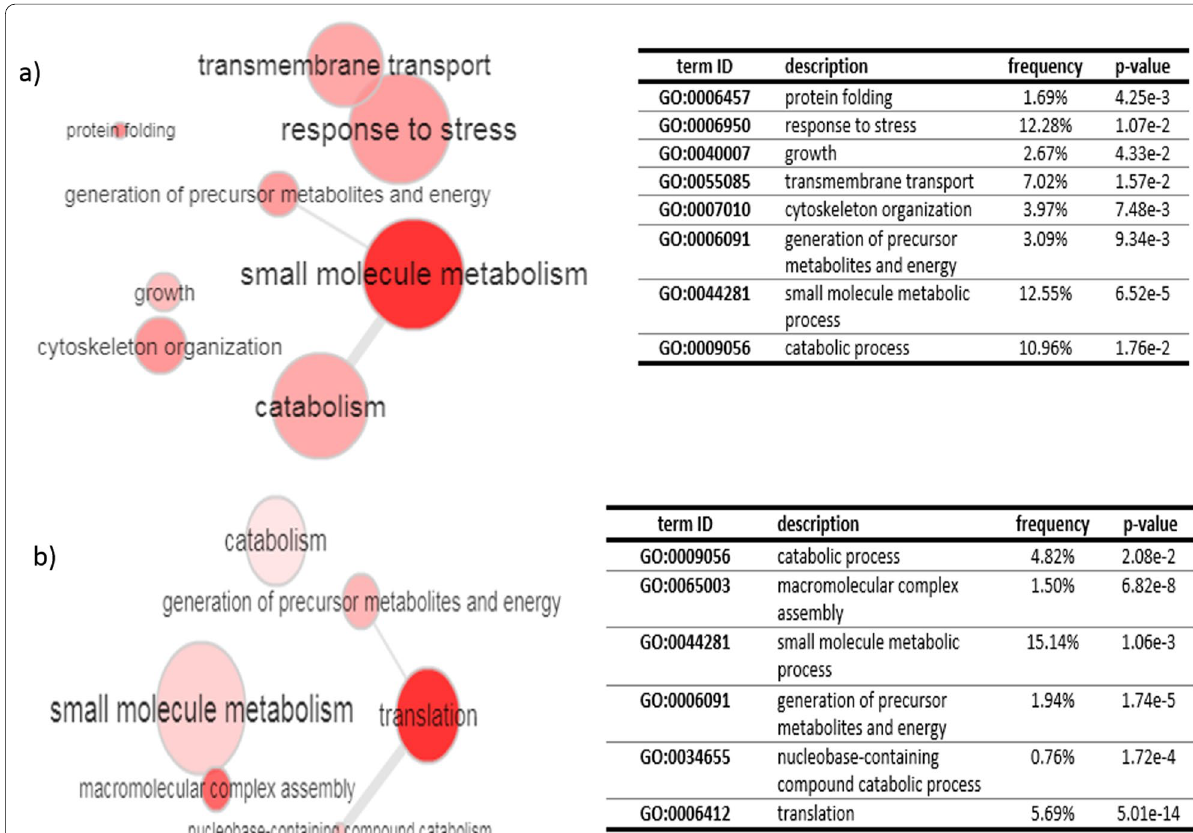
Fig. 3 Gene ontology enrichment analysis of differentially expressed proteins based on biological process enrichment during conversion of metacyclic promastigotes into the amastigote like of Iranian isolates of L. tropica by TriTrypDB (kinetoplastid Genomics Resource): a up‑regulated proteins and ( b ) down‑regulated proteins. The circles color and size are corresponded on the p‑value and frequency, respectively. The dark circles are related to high significance (low p‑value) and large sizes are also related to higher frequency